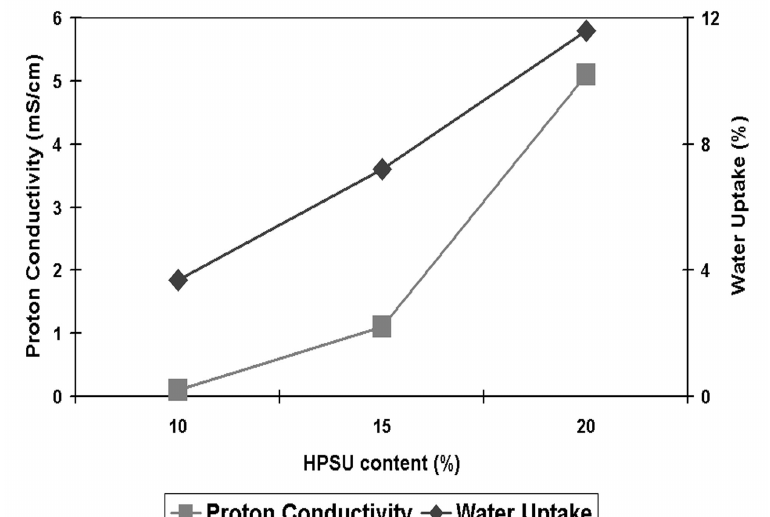
Figure 11. Ionic conductivity at 80 °C and 100% humidity and water uptake of samples containing 10%–20%